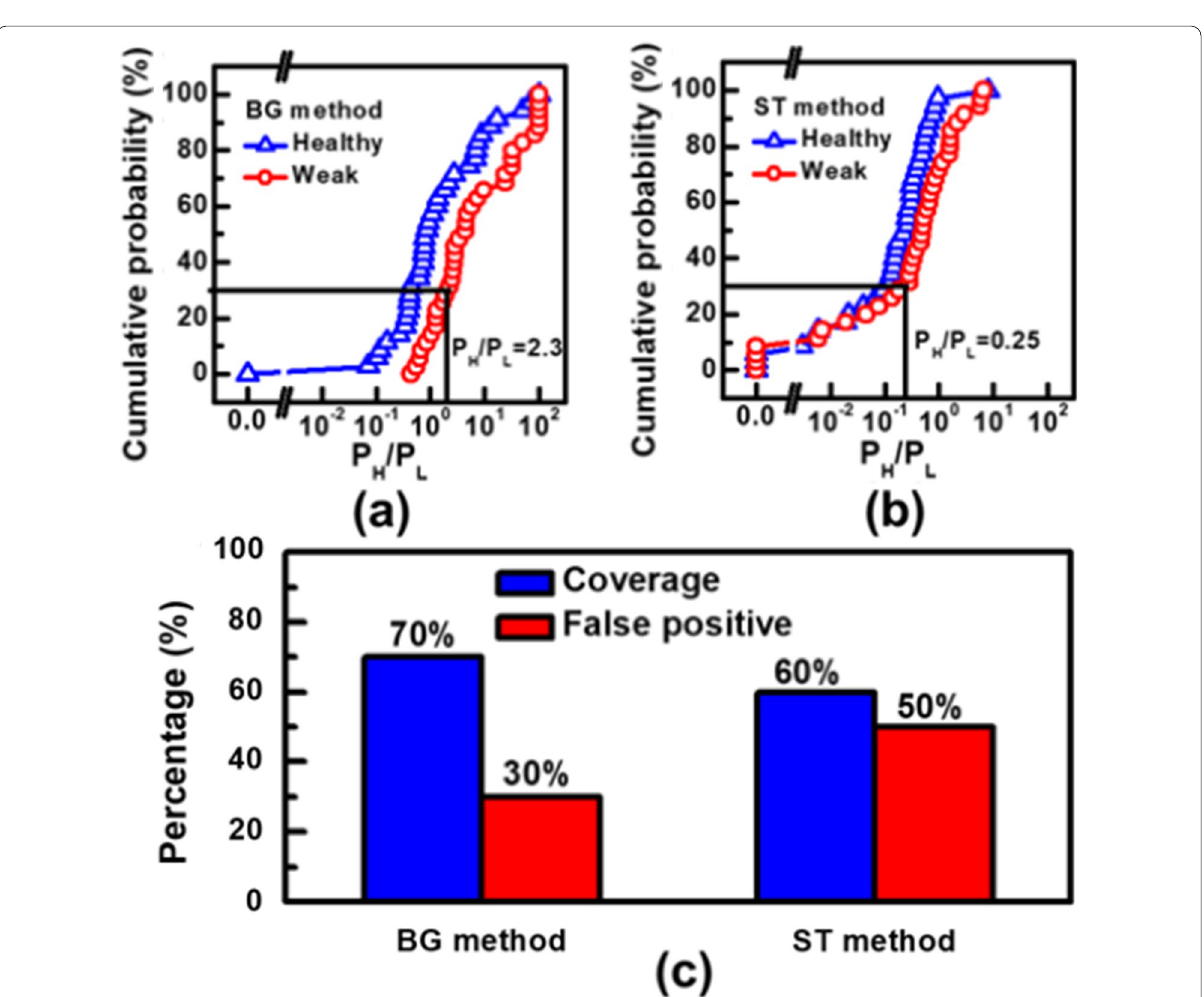
Fig. 10 Cumulative distribution of ratio of probabilities in high/low logic states on different cells types in a BG method, b ST method. c Comparison of coverage rate and false positive rate between two circuit